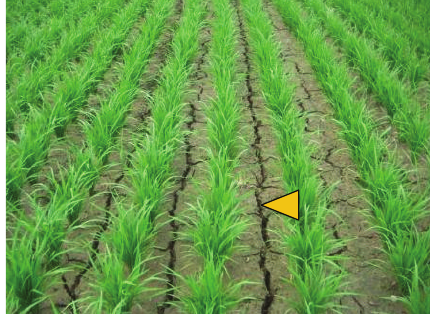
Figure 4: Dried soil of a paddy field in which the wet/dry cycles have been applied in the tillering stage. Note that deep cracks are recognized as lines (yellow arrowhead) between the rows of rice